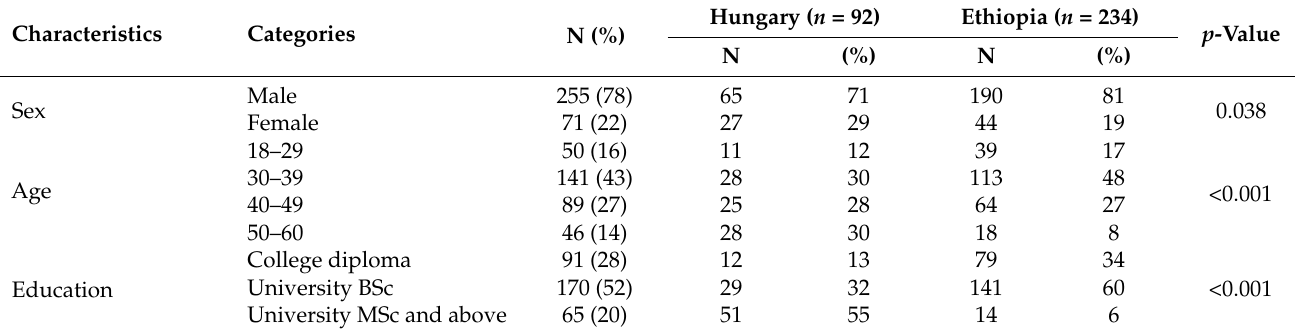
Table 2. Socio-demographic characteristics of respondents in Hungary and